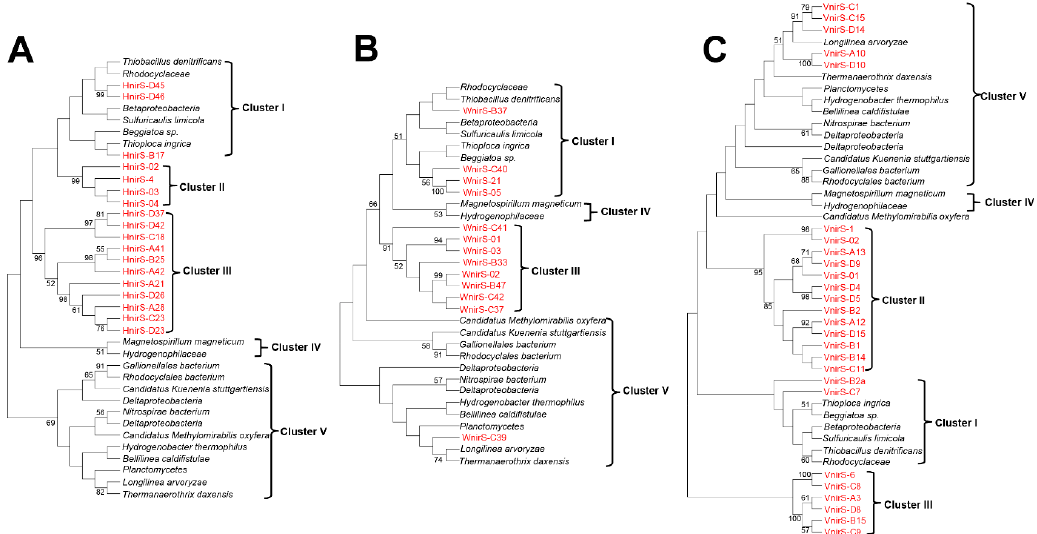
Figure 3. Analysis of nitrite reductase (nirS) gene sequences constructed based on protein sequences using the neighbor ‐ joining method. Sequences from this study are shown in red ( A ) sample QL ‐ H; ( B ) sample QL ‐ V; ( C ) sample SR ‐ W. Other representative nirS from the protein database and GenBank